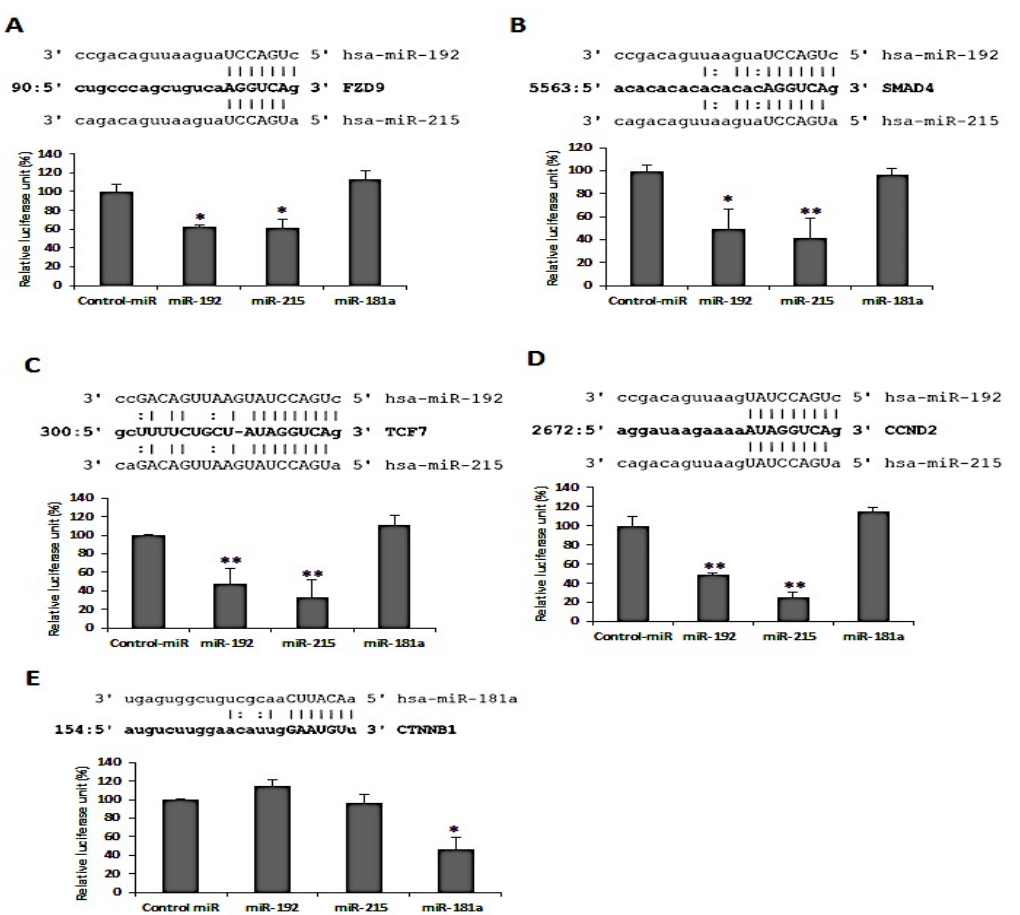
Figure 3. miR-192 family and miR-181a target key regulators of Wnt/ β -Catenin signaling pathway. Cloning of the 3 ′ UTR of some of the intermediates of the Wnt pathway followed by Luciferase reporter assay revealed that ( A – D ) FZD9, SMAD4, TCF7 andCCND2 are the direct targets of miR-192 andmiR-215; whereas, ( E ) miR-181a is responsible for targeting CTNNB1 or β -catenin itself. * p < 0.05, ** p <